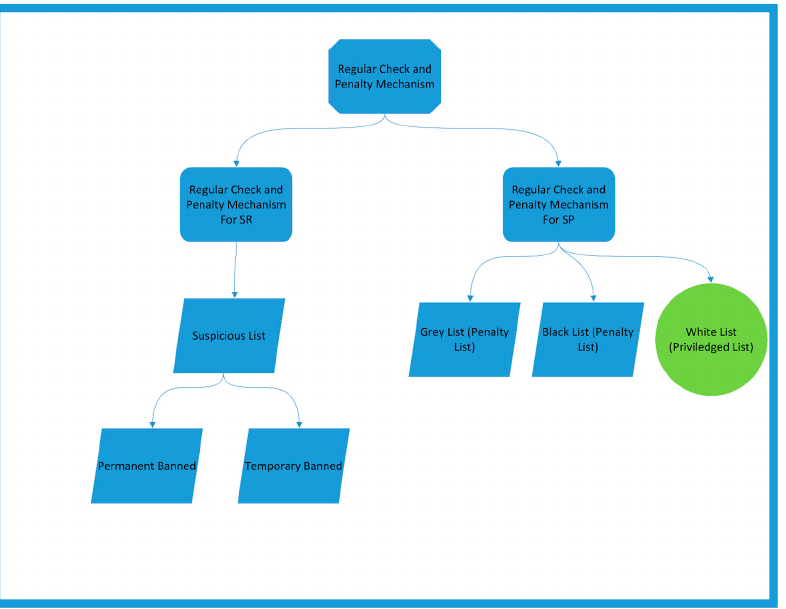
Figure 2. Regular Check and Penalty Mechanism.